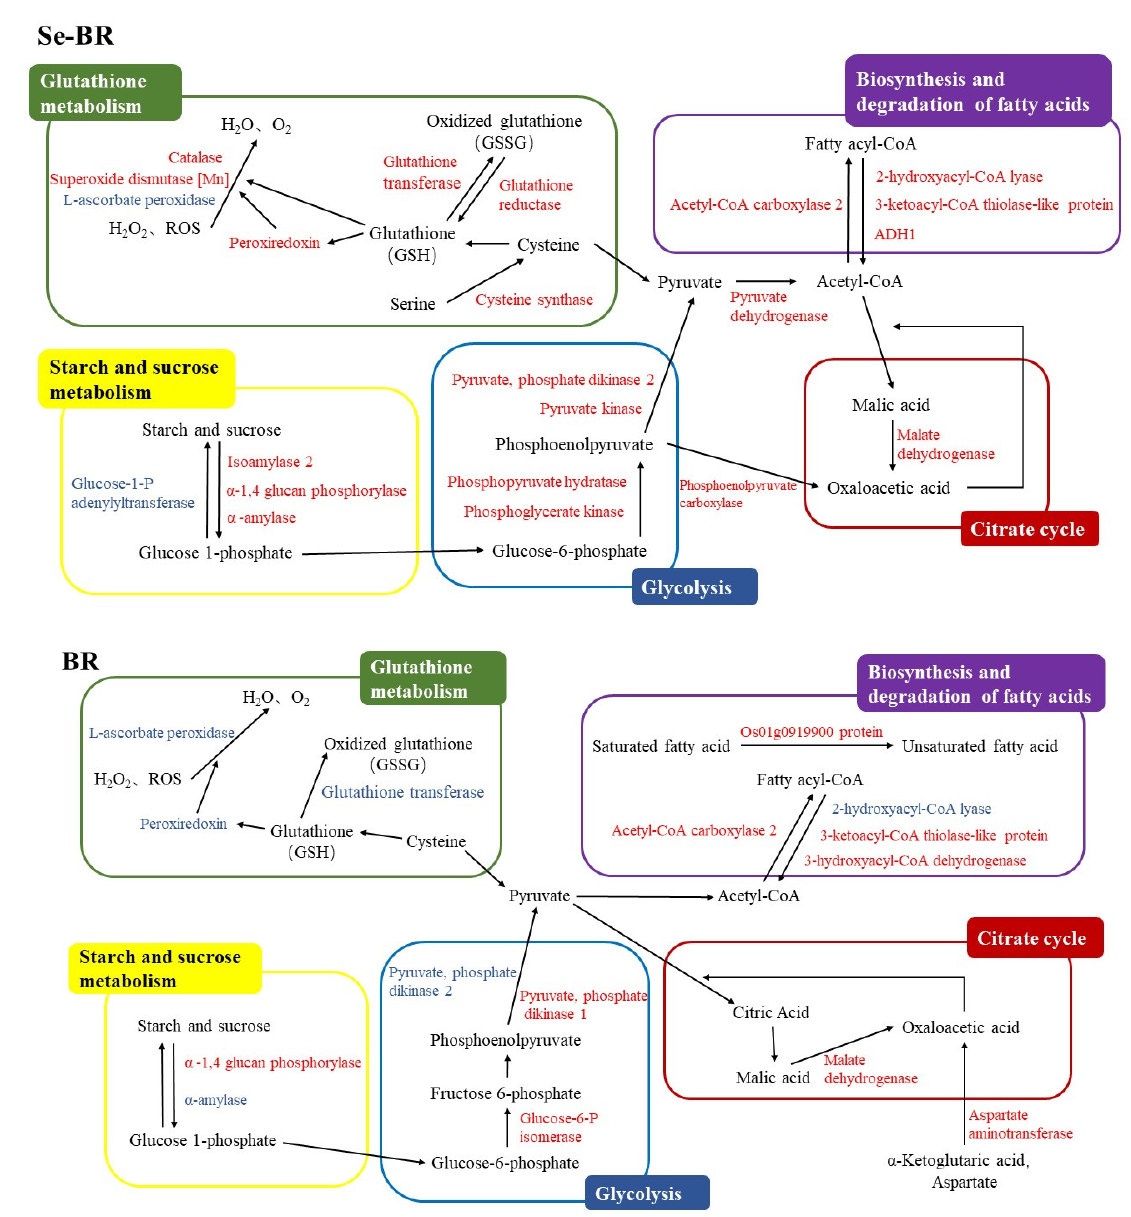
Figure 4. DEPs in the expression of Se-BR and BR in different metabolic pathways. Different metabolic pathways are distinguished by different colored boxes. Metabolic process substances are connected by arrows, and the direction of the arrow represents the direction of metabolism. Upregulated and downregulated proteins are marked in red and blue,